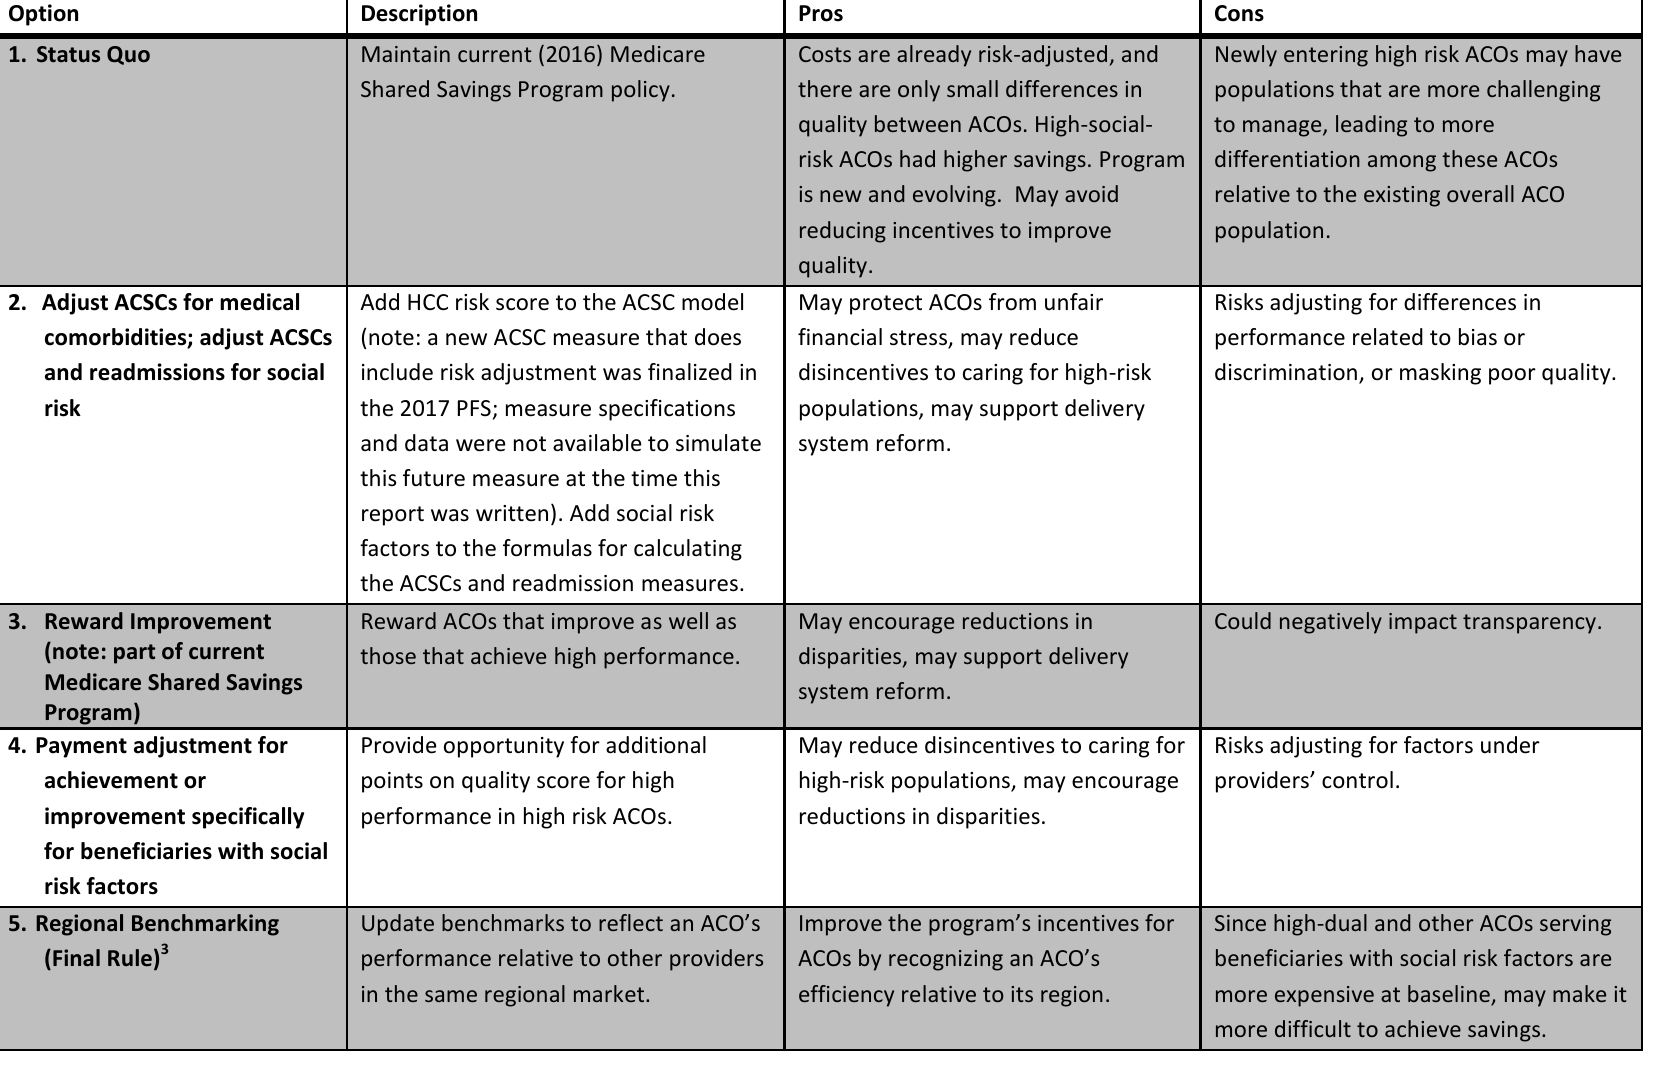
Table 9.12: Summary of Medicare Shared Savings Program Policy Options